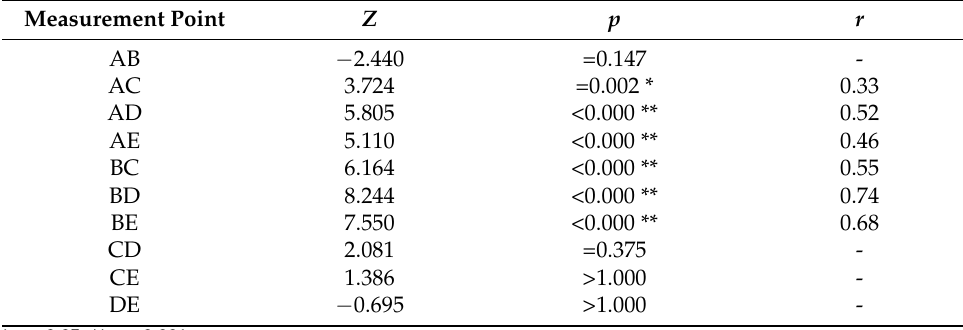
Table A7. Ceramic 5y_PM ( χ 2 (4) = 99.73; p < 0.000); N =